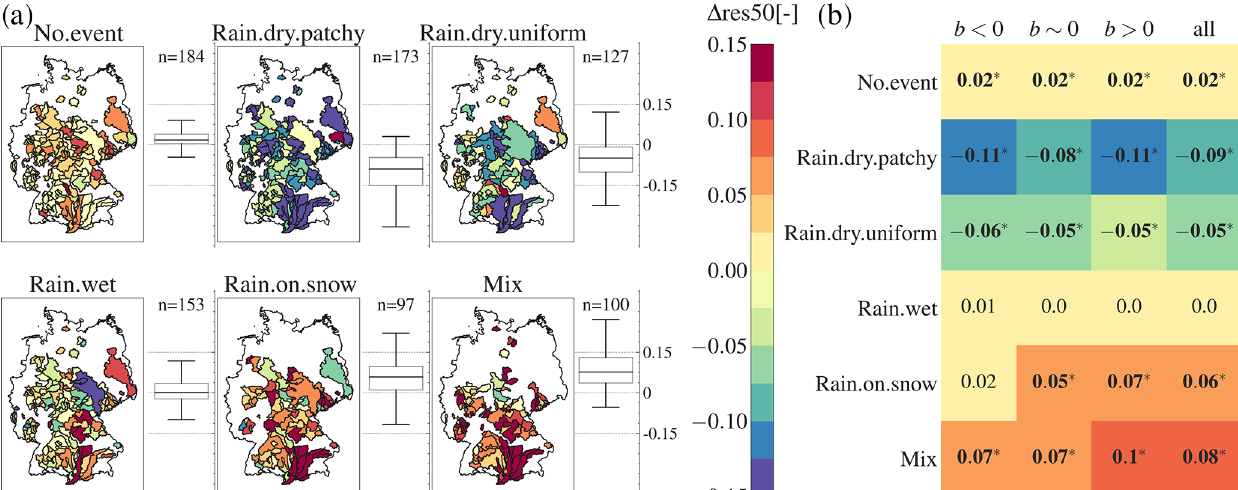
Hydrol. Earth Syst. Sci., 26, 6227–6245,